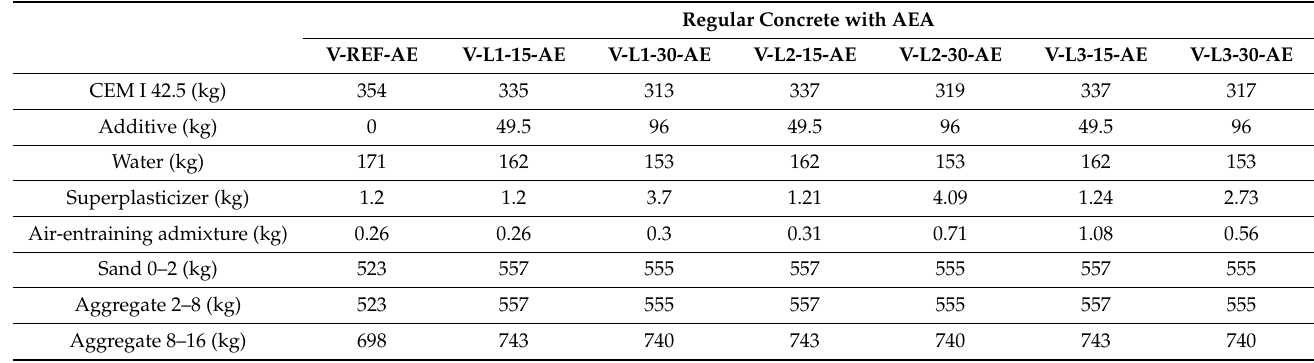
Table 3. Composition of 1 m 3 of vibrated concrete with air-entraining admixture.